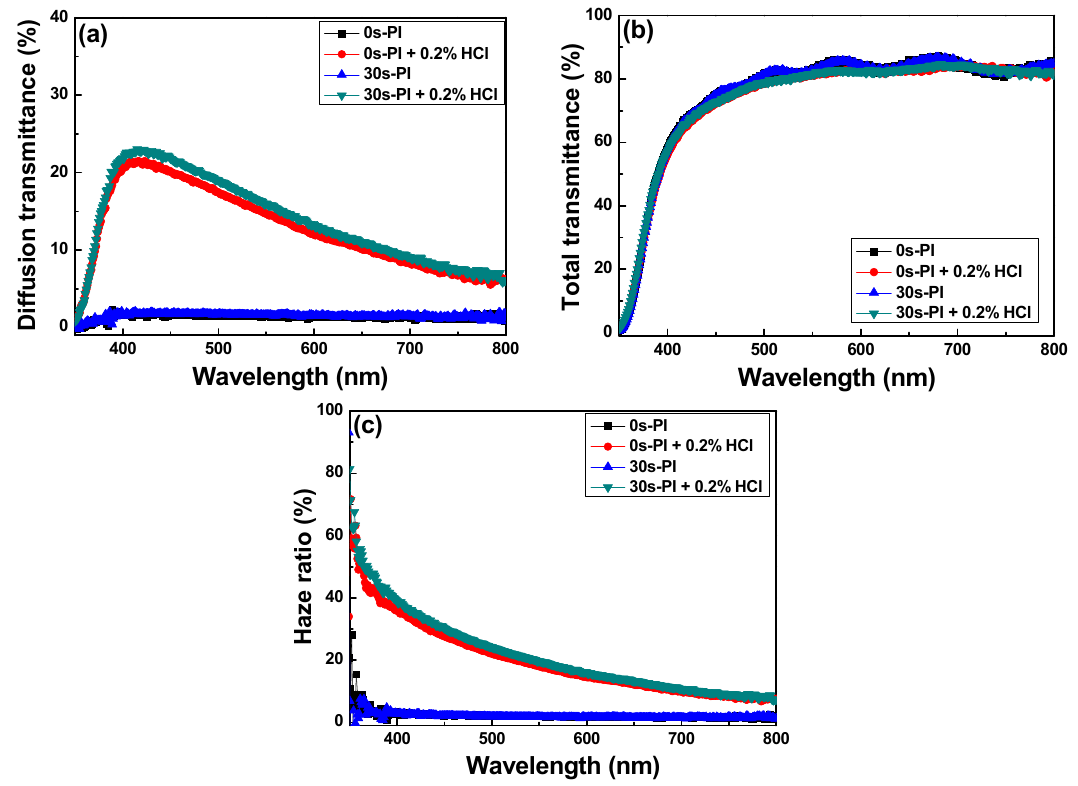
Figure 13. ( a ) Diffusion transmittance, ( b ) total transmittance, and ( c ) haze ratio of FZO films as functions of O 2 plasma pretreatment time and HCl etching.